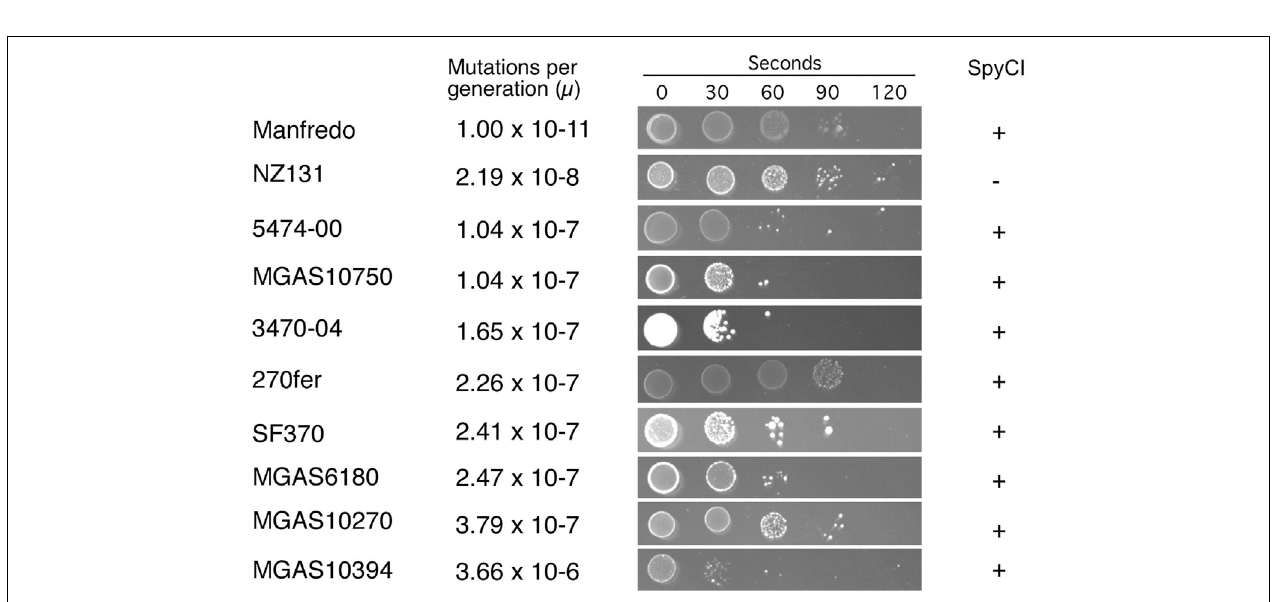
is shown for each strain. UV exposure time in seconds is indicated at the top and all strains were plated at the same dilution. All experiments were performed at least three times for each strain.